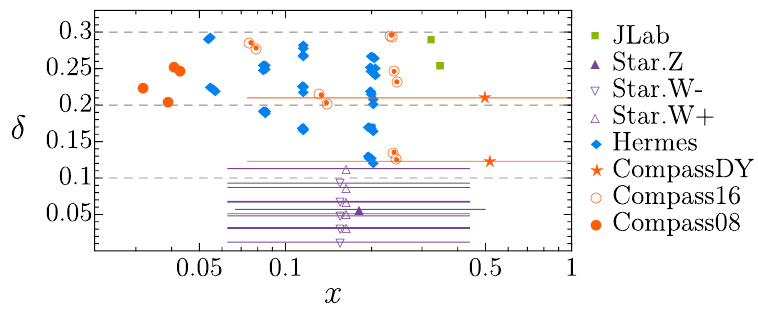
Figure 2. Distribution of the experimental data over the values of x and δ eq.